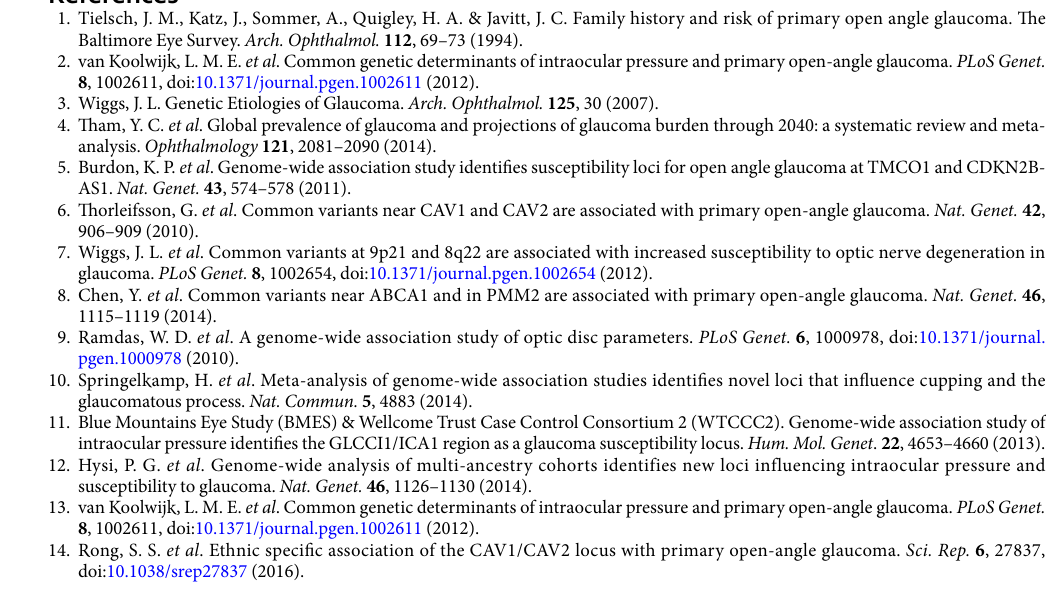
7 Scientific RepoRts | 7: 4393 | DOI:10.1038/s41598-017-02299-7